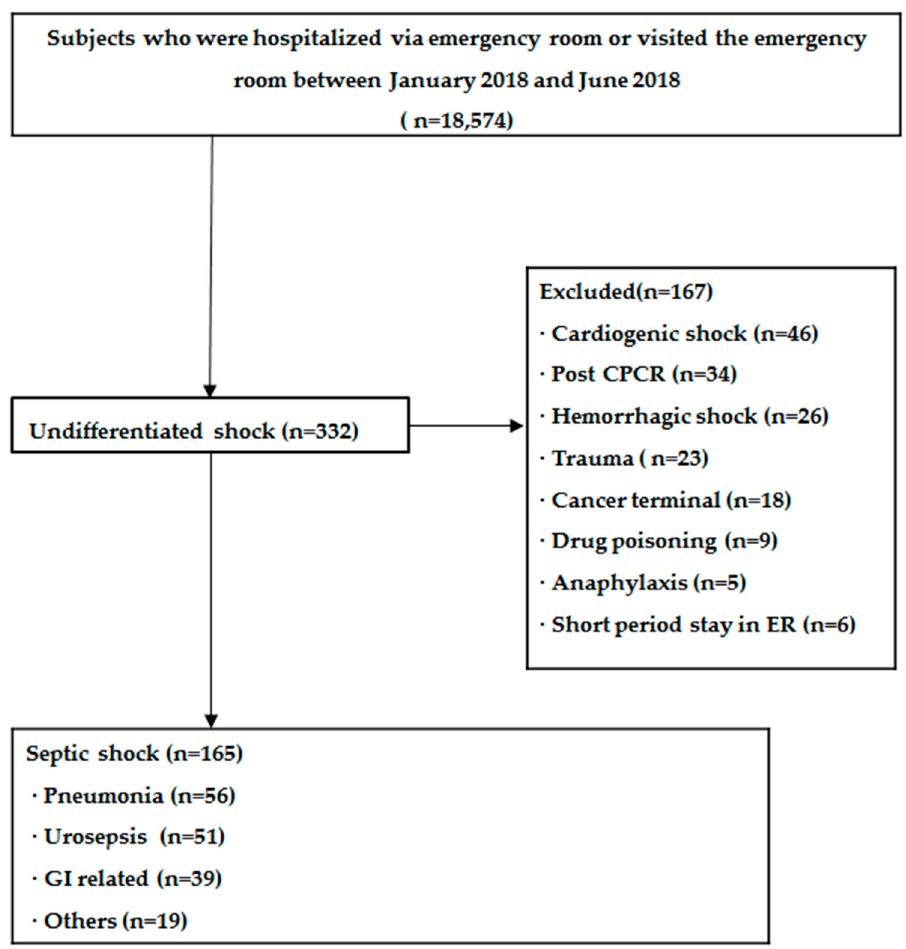
Figure 1. Flow chart of